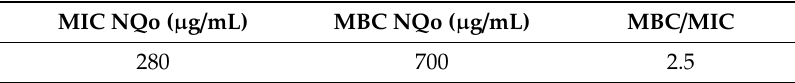
Table 1. Susceptibility of Pseudomonas sp. to NQo.